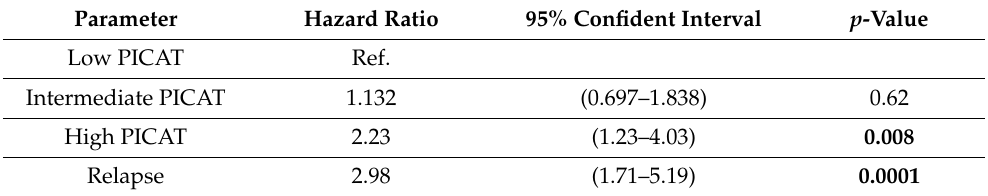
Table 4. Multivariate COX model of prognostic factors of OS.